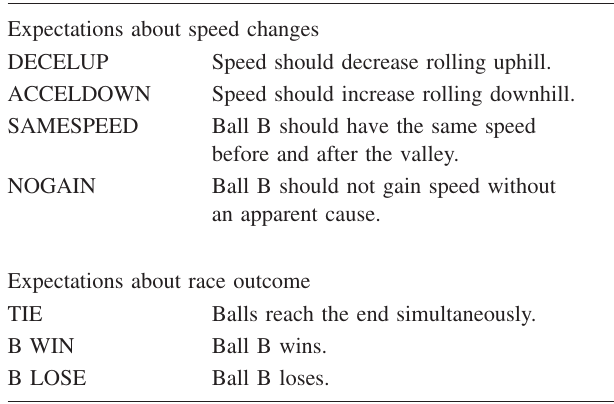
TABLE IV. Expectations commonly expressed about realistic motion in the one-ball and two-ball